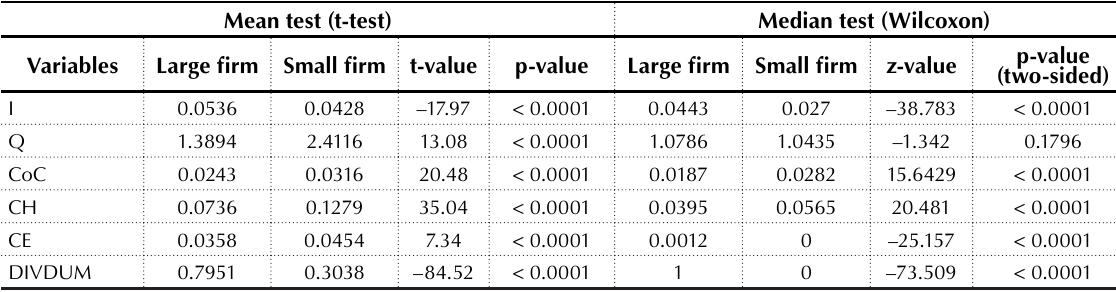
Table 3. Mean and median tests between large and small firm